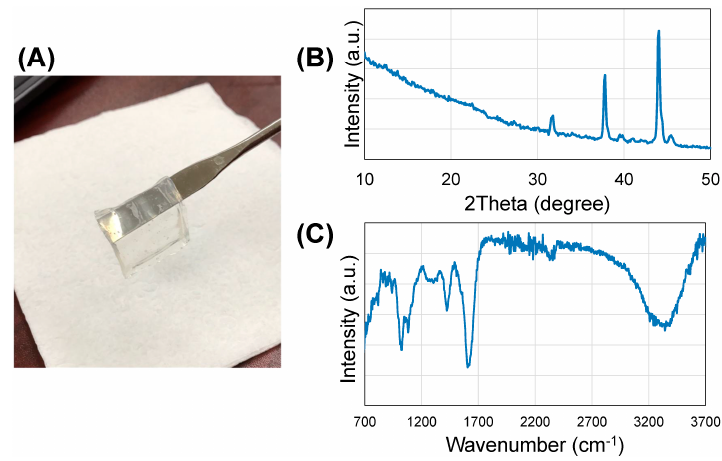
Figure 1. ( A ) Hydrogel sheet; ( B ) XRD spectra of the hydrogel; ( C ) FTIR spectra of the hydrogel.